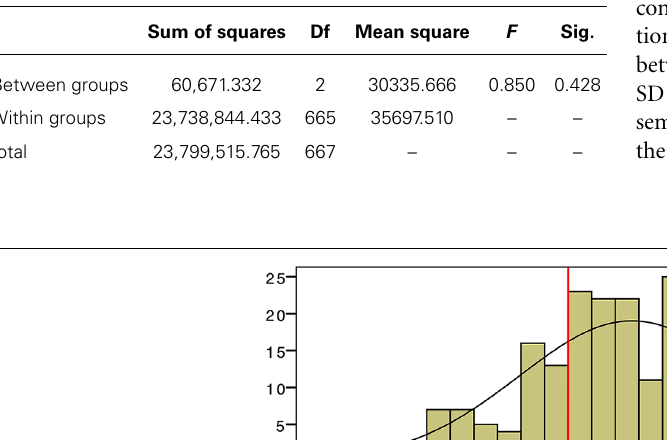
Table 4 | t -test of theATA between the three conditions.